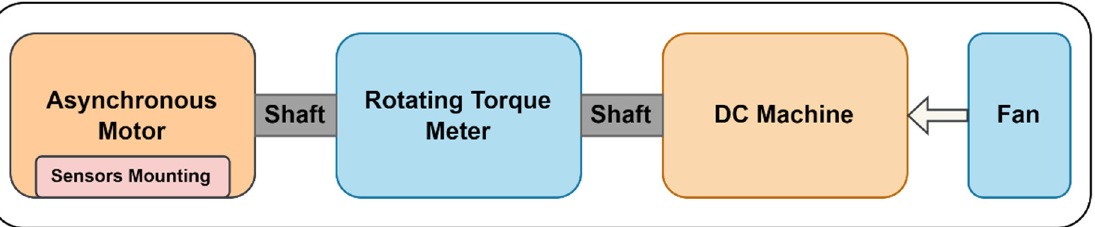
Figure 1. The block diagram of experimental workbench for collecting and generating a